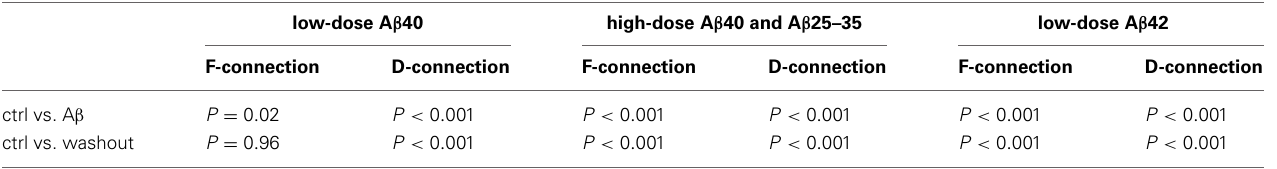
Table 1 | Comparison results of EPSP trains recorded in pre-application, application and washout of A β .